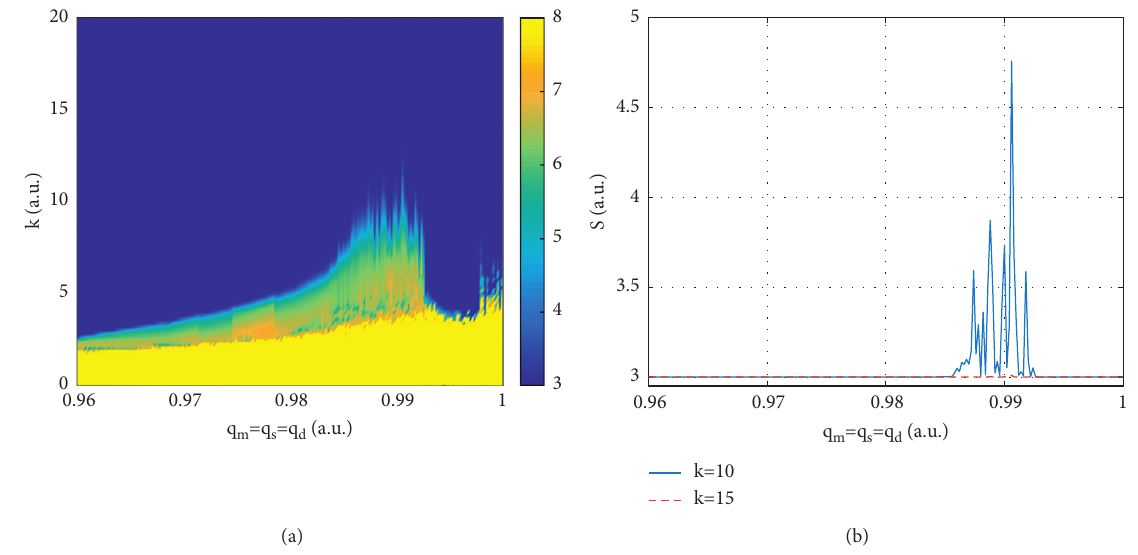
Figure 4: Numerical results for equations (18)–(20). (a) Limit behavior of the system as a function of coupling strength k and integration order q . (b) Synchronization index equation (14) as a function of integration order, for a fixed k � 10 and k � 15. A value of S � 3 indicates complete